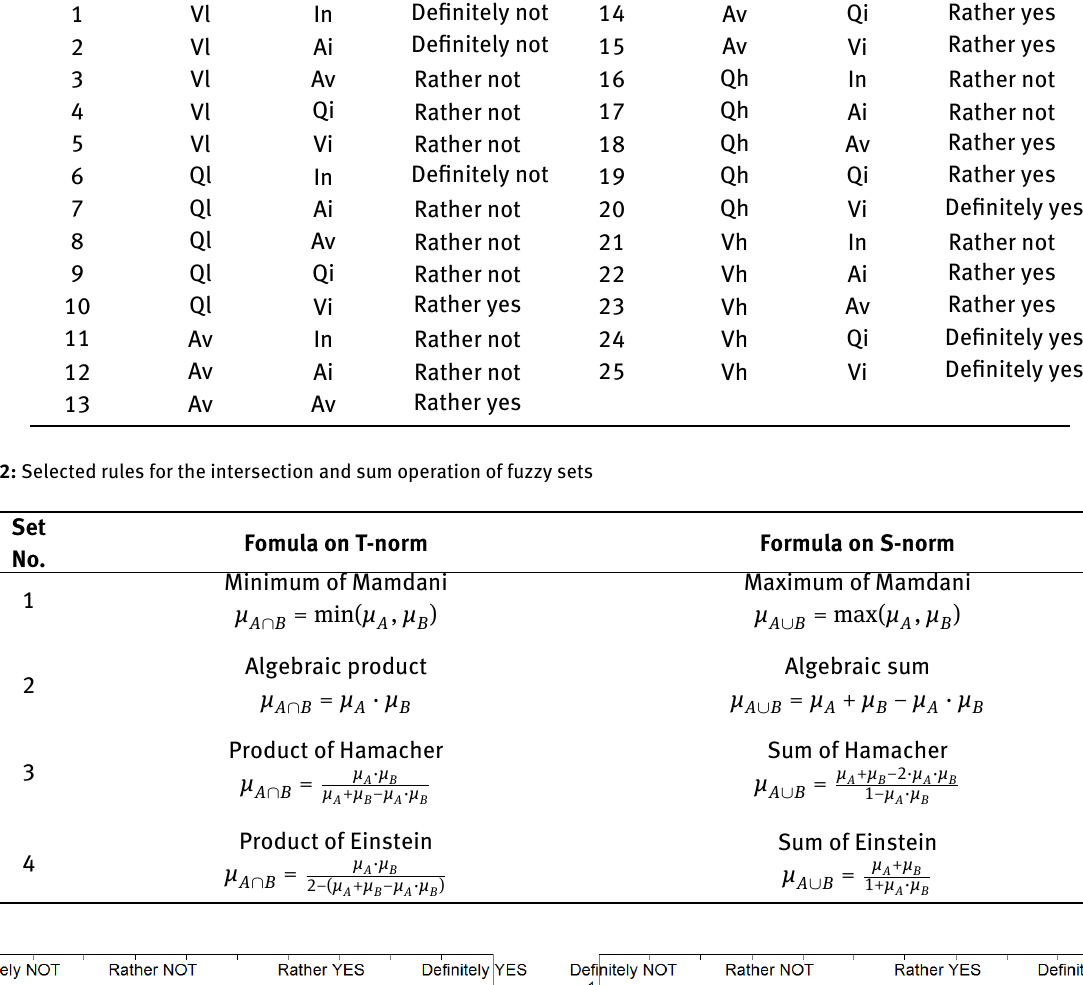
Table 1: Rule base for the inferential block Rule No.